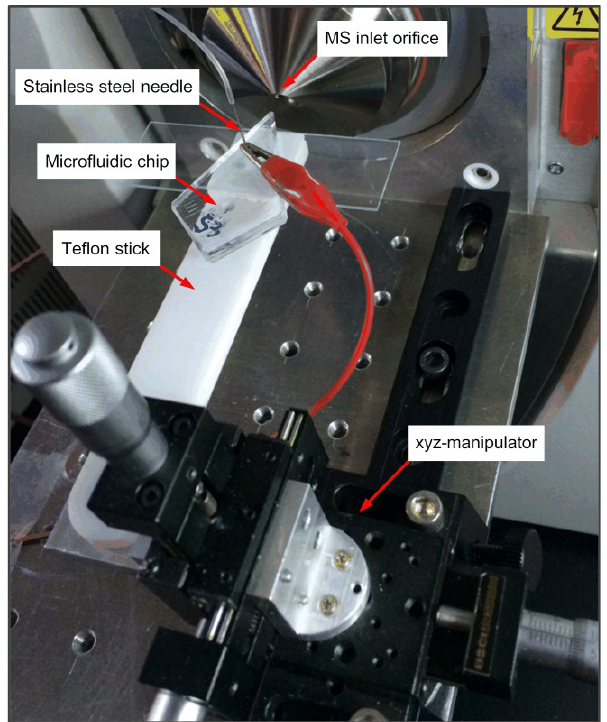
Figure 3. Experiment platform. A laboratory-built platform was set up on the commercial ion trap MS to perform the microchip experiments.